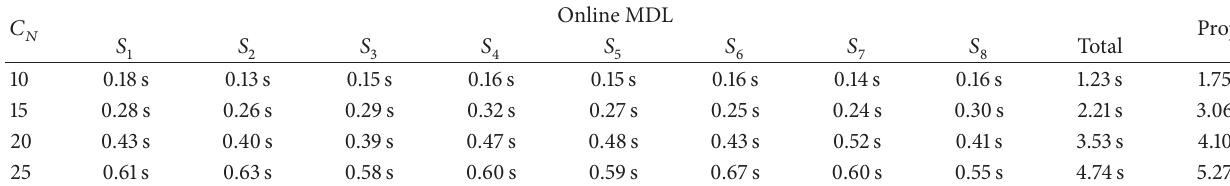
Figure 11: Boxplot of classification accuracy. Table 5: Time cost of 8 sensors.